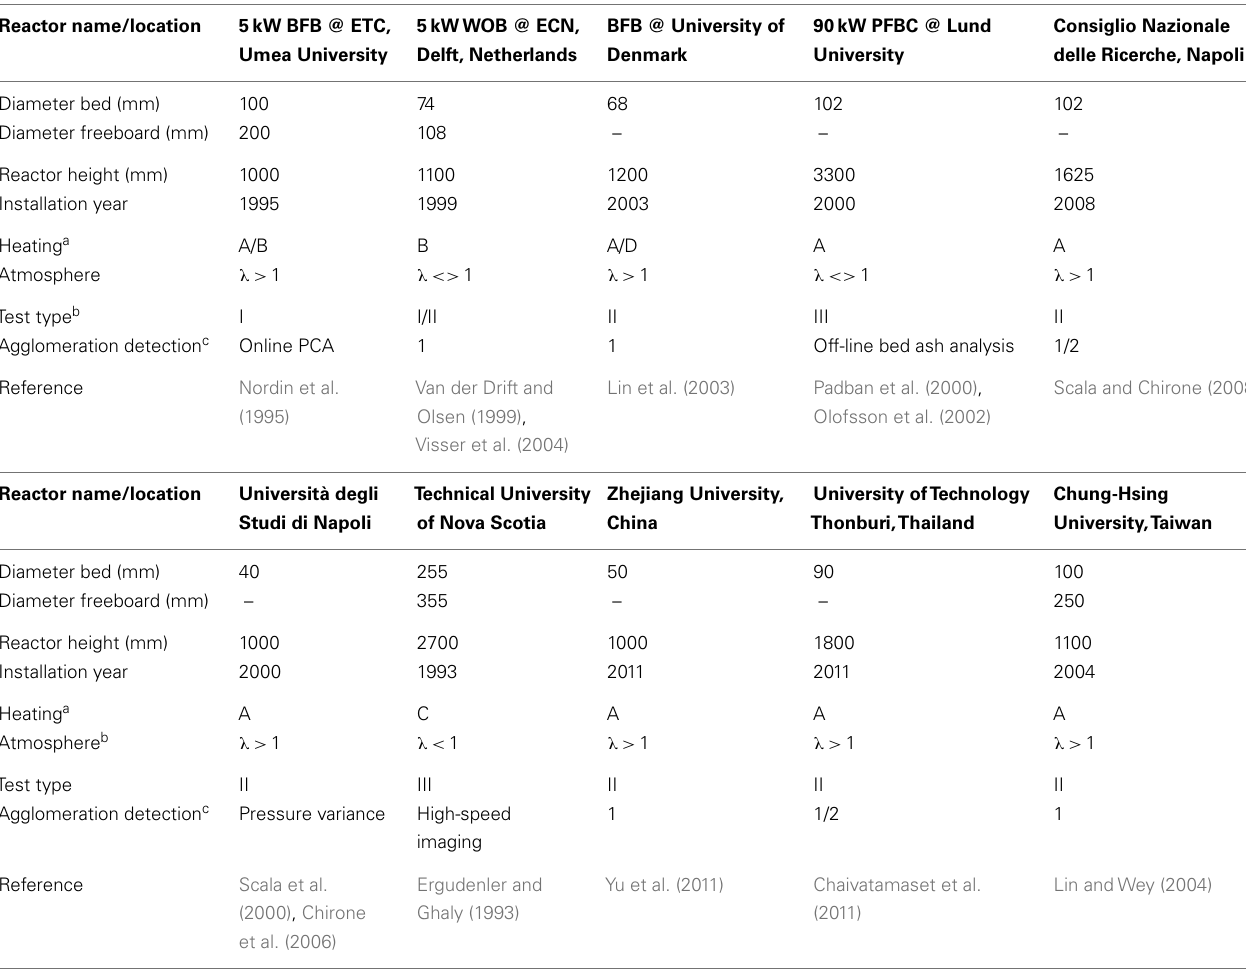
Table 1 | List of lab scale reactors used for controlled agglomeration tests